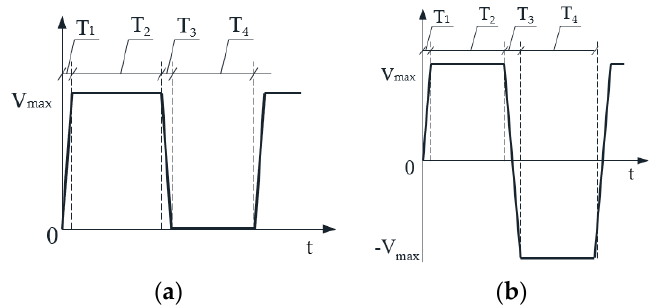
Figure 7. Voltage control scheme. ( a ) Single pulse; and ( b ) double pulse. T1: Rising stage; T2: Opening stage; T3: Falling stage; T4: Dispensing stage.